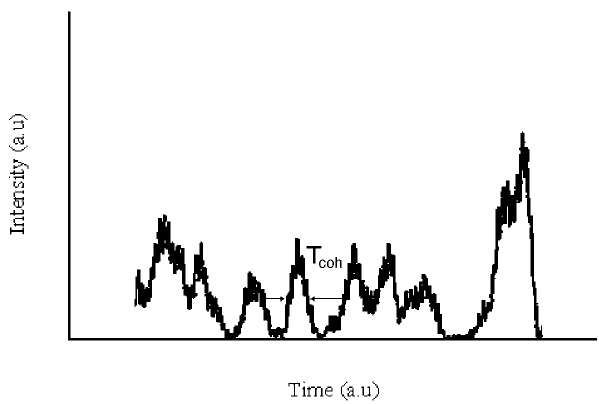
FIG. 1. Intensity spiking in the time domain (arbitrary units). The width of the peaks is characterized by the SASE coherence p (cid:3) (cid:1)(cid:1)(cid:1)(cid:1) (cid:9) =(cid:10) time T ! coh